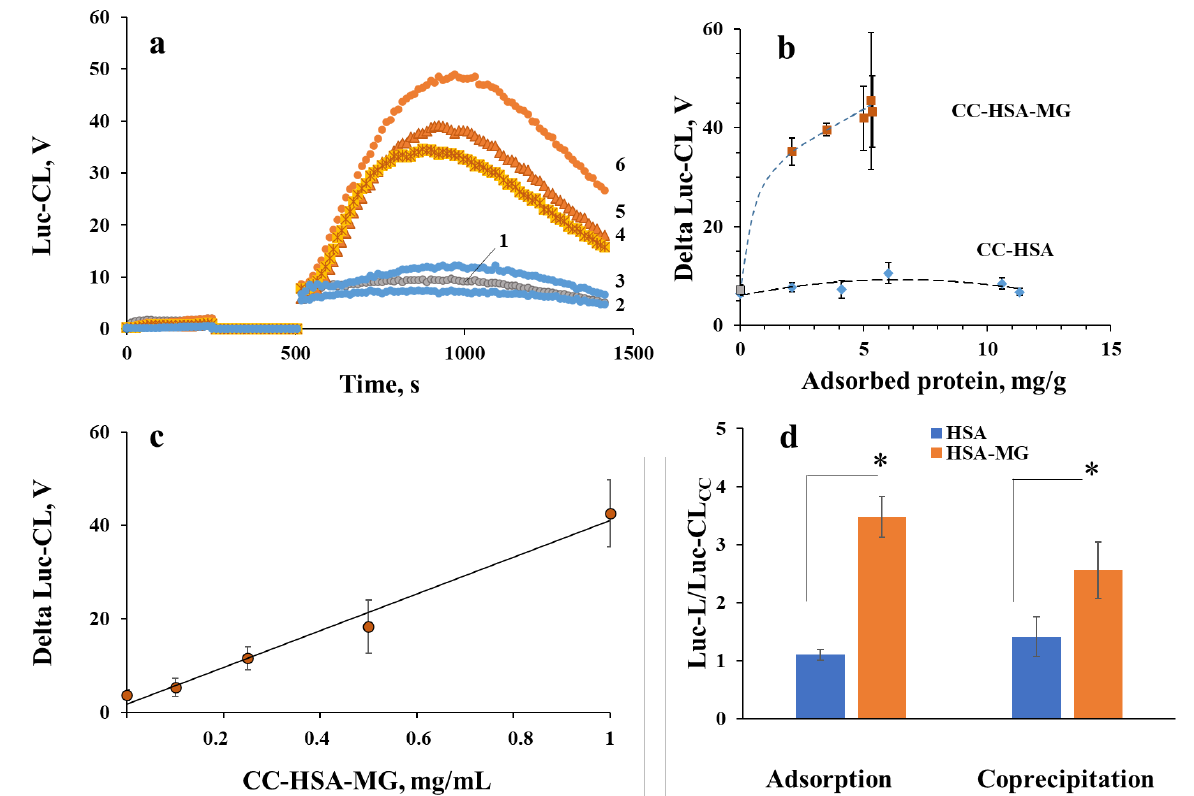
Figure 5. Luc-CL of neutrophils, stimulated by CC with adsorbed proteins: kinetics ( a ) for CC without proteins (curve 1), with 11 mg/g and 6 mg/g HSA (curves 2 and 3), and with 2.1 mg/g, 3.5 mg/g, and 5 mg/g HSA-MG (curves 4, 5 and 6). Amplitude ( b – d ) is presented as a function of the quantity of adsorbed protein ( b ), of the concentration of CC-HSA-MG (with protein inclusion of 6 mg/g) ( c ) and, in comparison, with CC, coprecipitated with HSA and HSA-MG ( d ). * p < 0.05 vs. CC-HSA (according to Student’s t -test).